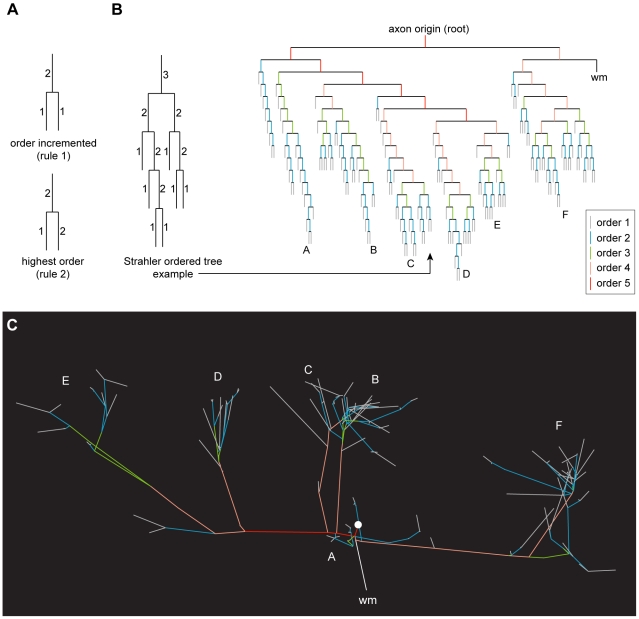
Topological ordering of an axonal tree.(A) Strahler ordering scheme maps axonal tree topology by applying two rules to increment the order of parent branch when its descendant branches have the same order (rule 1, upper) otherwise setting the order to the maximum order of children branches (rule 2, lower). Hence, in this centripetal ordering scheme terminal branches are labelled first-order and the root branch (axon origin) given highest branch order. Example application of order scheme to whole pyramidal cell axonal tree illustrated by (B) dendrogram (right), where each vertical line was colour-coded to represent branch order (see key) and black lines represents links except for section leading to white matter (wm), with a labelled subtree (left) showing application of numbering scheme, and (C) coronal view of axon graph representation (direct distances between morphological landmarks) with colour coded branches to match the dendrogram representation shown in (B).